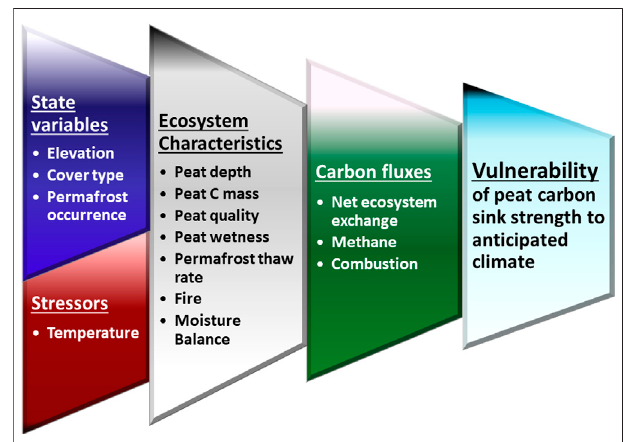
FIGURE 1 | Conceptual framework used in this study to assess vulnerability of peatland carbon to climate